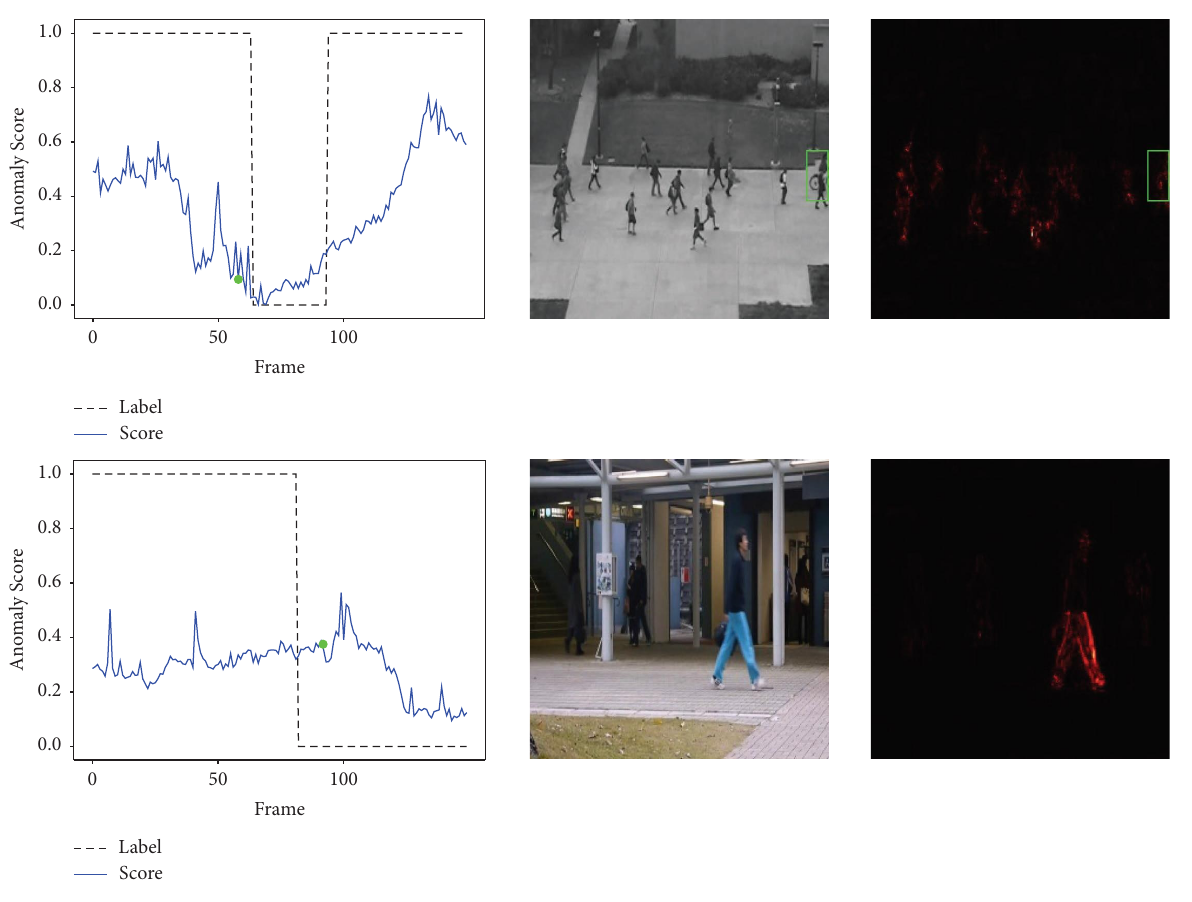
Figure 16: Abnormal behavior detection